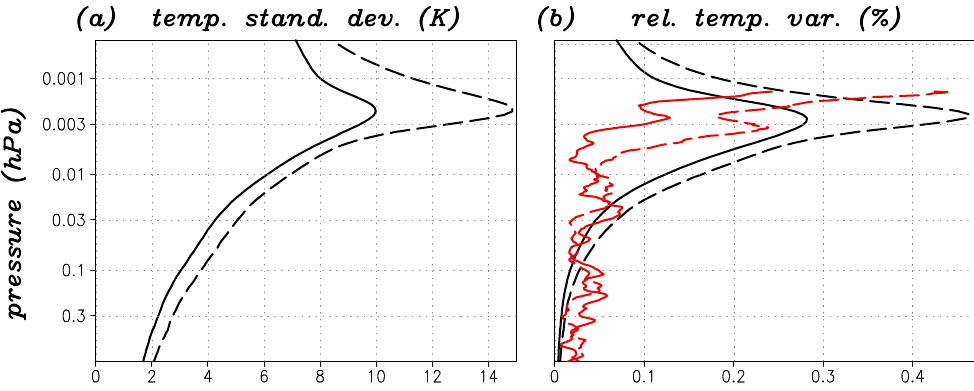
Fig. 9. (a) Zonal mean of the temperature standard deviation at 70 ◦ N in the “normal July” run (solid curve) and in the “July 2002” run (dashed curve). Only zonal wavenumbers m = 11 ... 85 are retained. (b) Black curves: Same as (a), but for the relative temperature variation. In addition, the red curves give observed relative temperature variations already presented by Rapp et al. (2004), which were compiled from soundings during years before 2002 (solid curve) and during the MaCWAVE year 2002 (dashed curve).